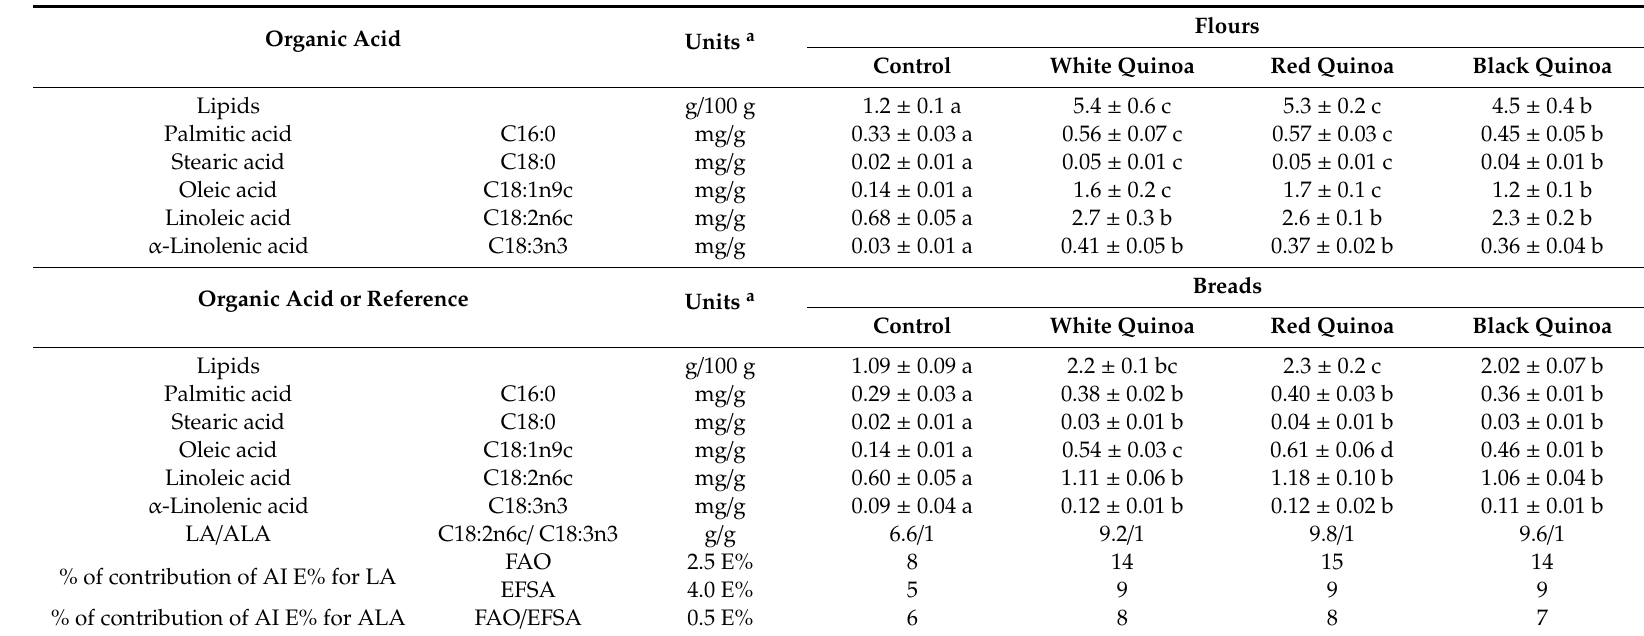
Table 2. Fatty acid composition of raw materials and breads and adequate intake